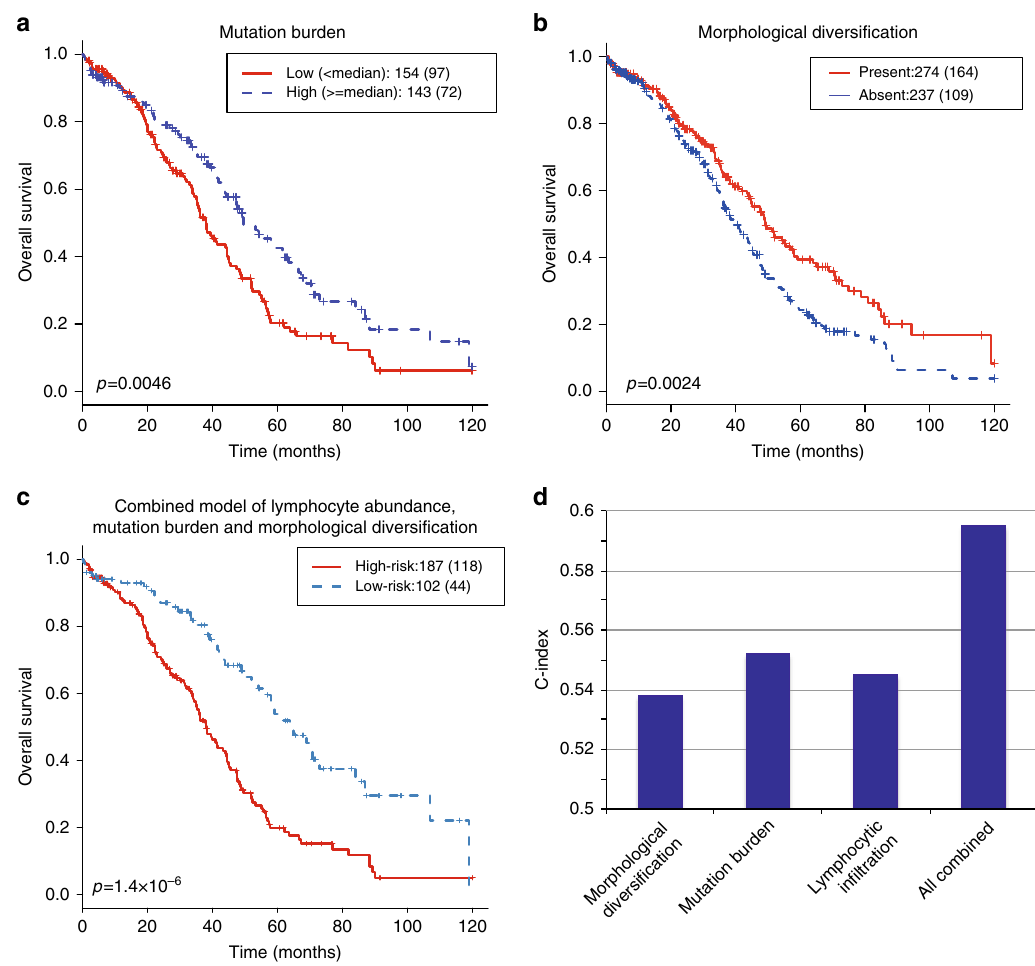
Fig. 4 Integrated model of mutation burden, lymphocyte abundance and morphological diversi fi cation. a Kaplan-Meier curves to show the difference in OS according to mutation burden . b Kaplan-Meier curves to show the difference in OS according to morphological diversi fi cation. c Kaplan-Meier curves for the combined model consisting of lymphocytic abundance, mutation burden and morphological diversi fi cation. High-risk group included the patients with low mutation burden and lymphocyte abundance, but when they were in disagreement (one high and the other low), morphological diversi fi cation was present. d Barplot showing the model concordance (C-index) for individual measures and